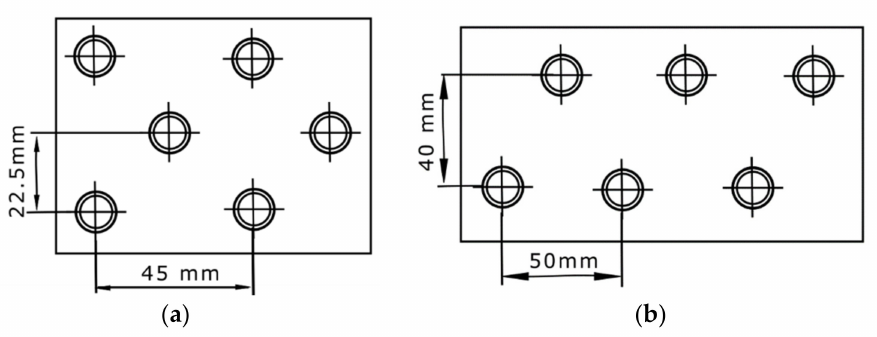
Figure 13. The schematic drawing of fin tubes geometries: ( a ) case 11, ( b ) case